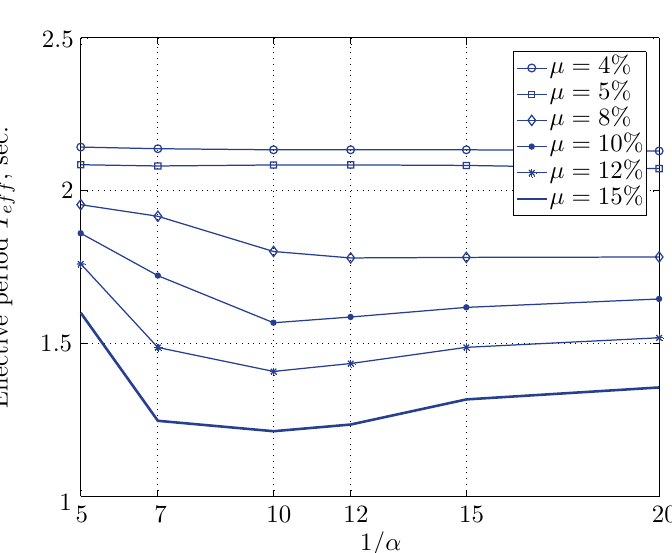
Figure 45. Effective period for various isolation system parameters (Yermo).